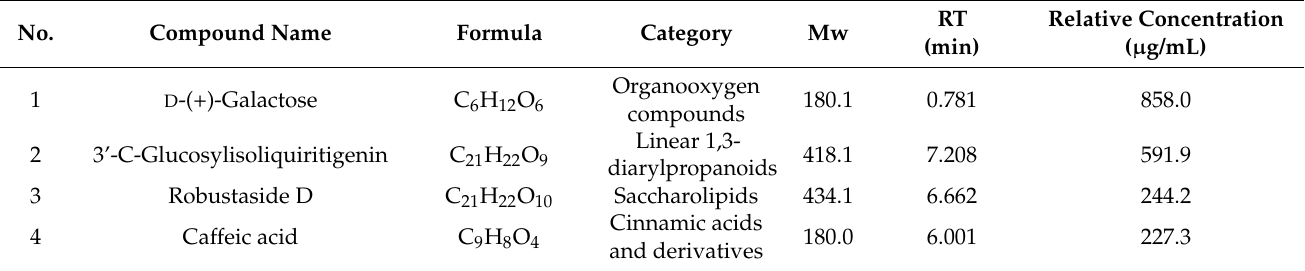
Figure 4. Total ion current chromatogram (TIC) of EAF from Pingguoli pear fermentation broth at negative ion mode. Table 5. Identification of ten main compounds in the EAF from Pingguoli pear fermentation broth by